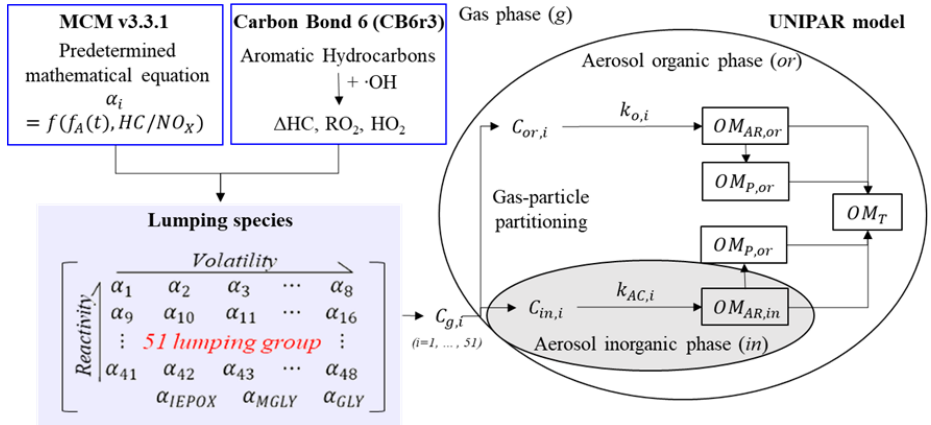
Figure 1. The structure of the UNIPAR-CB6r3 to predict the gasoline SOA formation. C g ,i , C or ,i , and C in ,i are the concentration of organic compound ( i ) in the gas phase (g), organic phase (or), and inorganic phase (in). The dynamic stoichiometric coefficient (dynamic α i ), the consumption of HC ( (cid:49) HC), the concentration of hydroperoxide radical ([HO 2 ]), and the concentration of organic peroxyl radical ([RO 2 ]) are simulated from the CB6r3. The aging scale factor ( f A ) is represented as a function of [HO 2 ], [RO 2 ], and the initial concentration of HC (Zhou et al., 2019). OM AR , OM P , and OM T indicate organic matter (OM) formed from aerosol-phase reactions, OM formed from the partitioning process, and total OM,